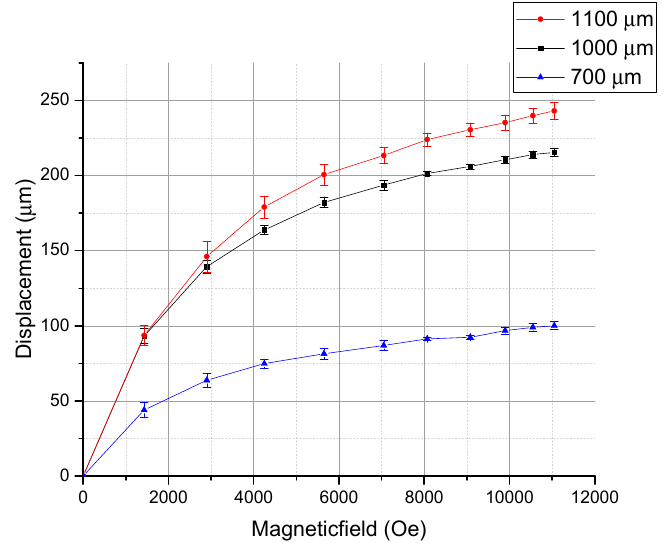
Figure 9. Observed displacements of the cantilevers with different lengths (700, 1000, 1100 µm).